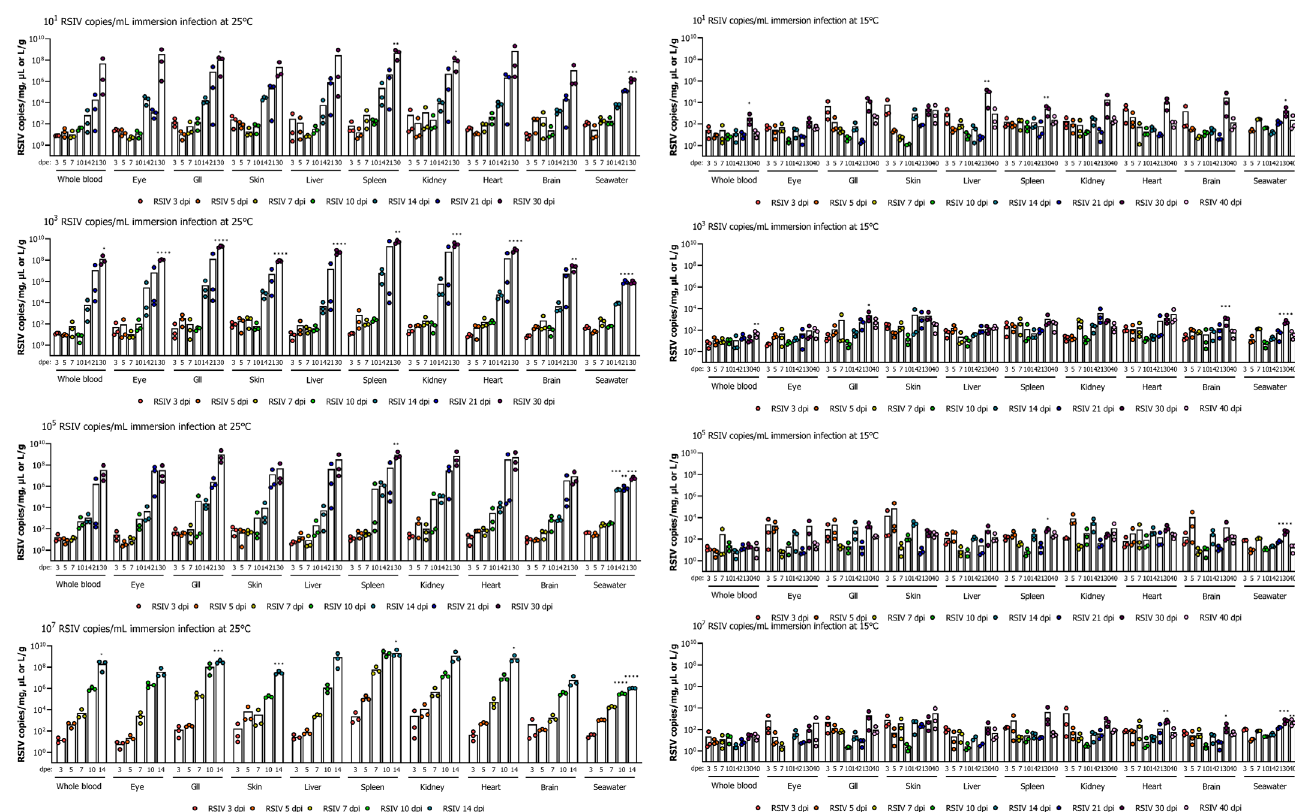
Figure 2. Viral load in various tissues (blood, eye, gill, skin, liver, spleen, kidney, heart, and brain) and RSIV shedding ratio in seawater after red sea bream iridovirus (RSIV) immersion exposure in rock bream ( Oplegnathus fasciatus ) at 25 ◦ C and 15 ◦ C at four concentrations (final concentrations: 10 7 , 10 5 , 10 3 , and 10 1 RSIV copies/mL). The RSIV shedding ratio (RSIV copies/L/g) was determined based on the total weight (g) of the fish remaining in the tank and the number of viral copies detected in the rearing seawater. Copy number determination of RSIV was analyzed in three fish and seawater per sampling interval. Significant differences were determined using a one-way ANOVA with Dunnett’s multiple comparisons test (* p < 0.05; ** p < 0.01; *** p < 0.001; **** p < 0.0001).